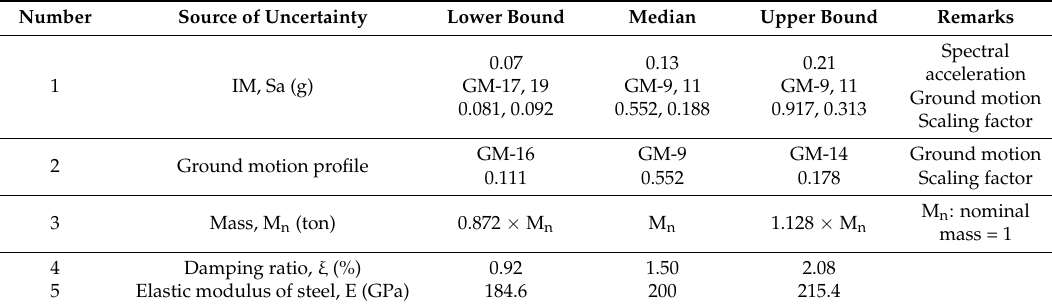
Table 5. Parameters of the sensitivity